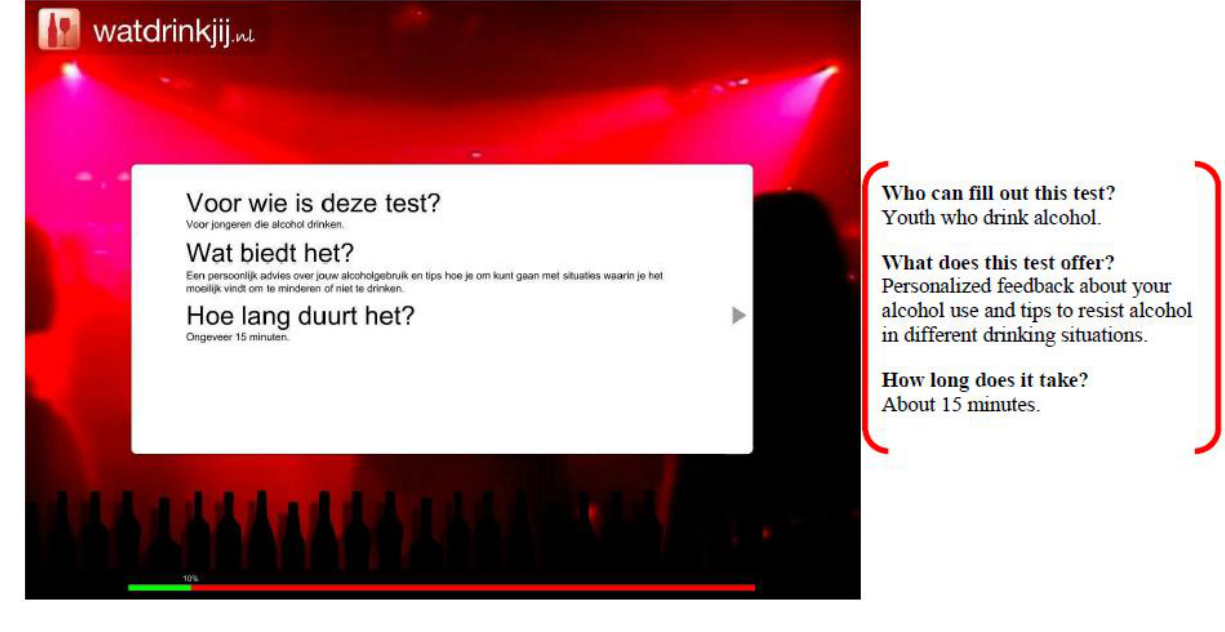
Figure 1. Screenshot and English translation of the What Do You Drink home